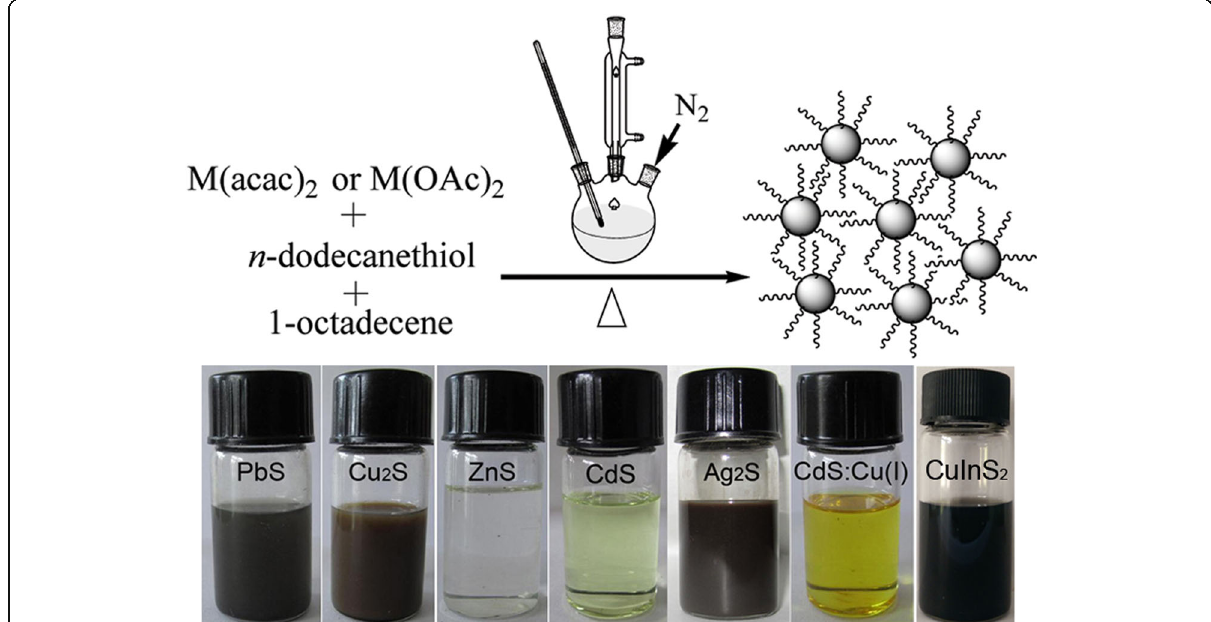
Fig. 1 Top panel, schematic illustration of the synthetic procedure for different inorganic NCs; bottom panel, photographs of different products dispersed in chloroform solutions at room